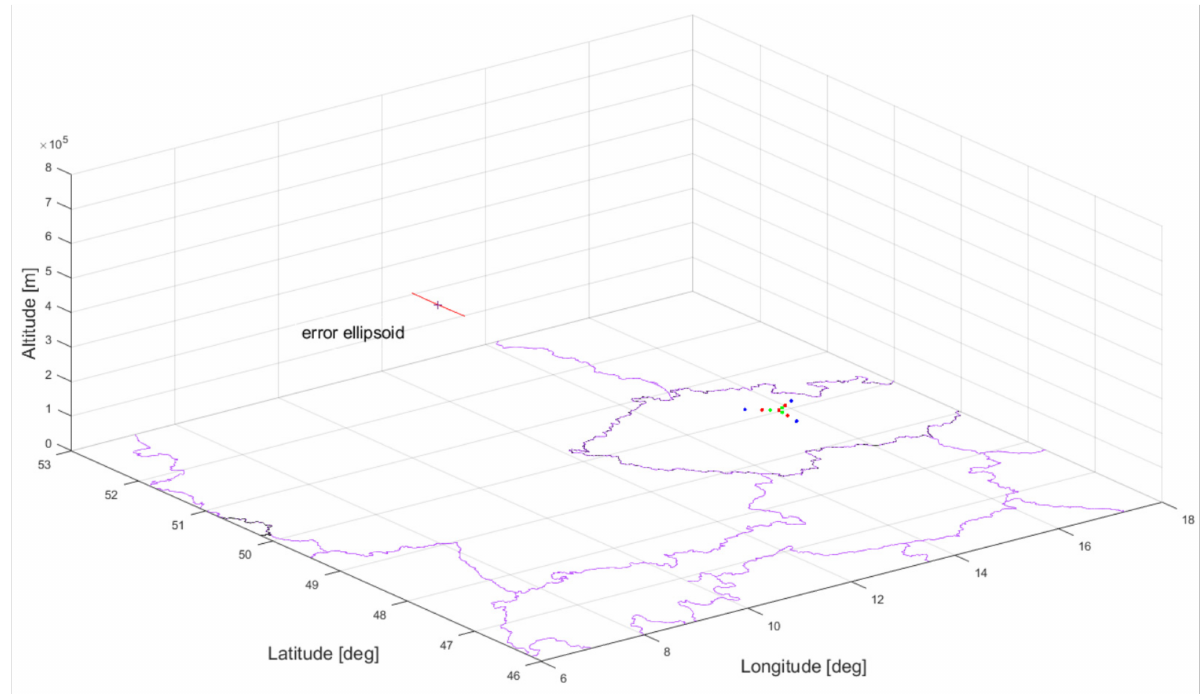
Figure 11. To scale image of the error ellipsoid and the ESM MLAT systems deployment.